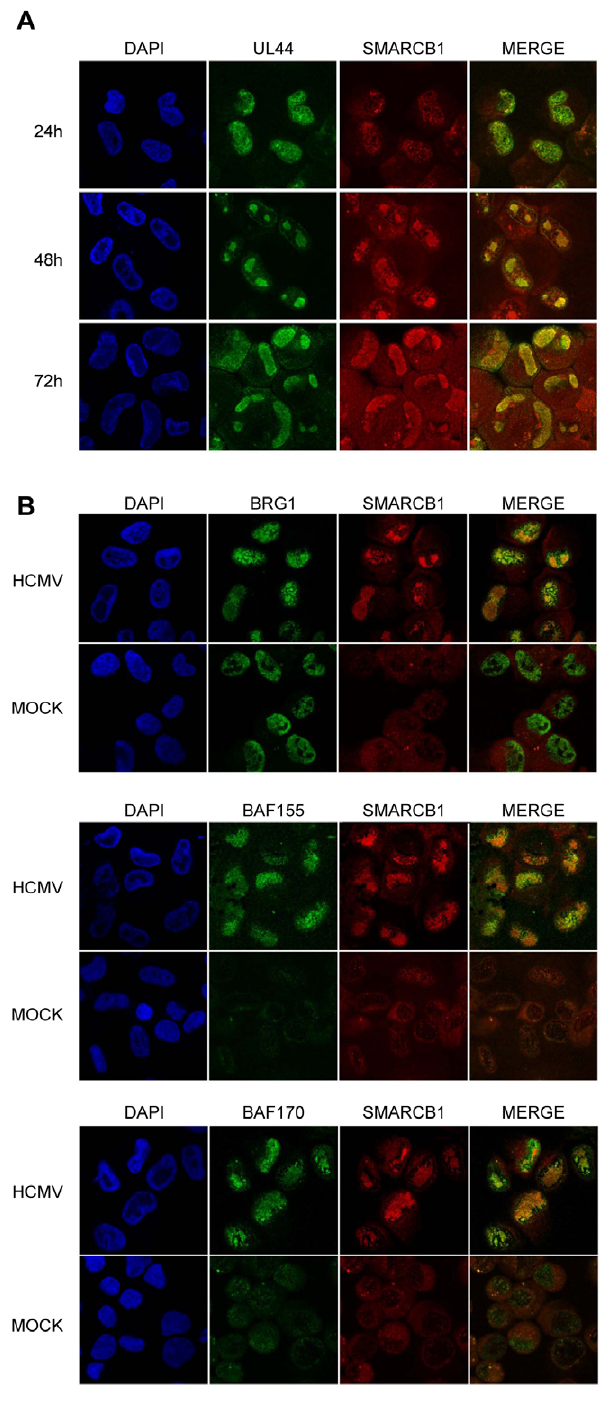
Figure 3. Recruitment of SWI/SNF chromatin remodeling factors to nuclear virus DNA replication foci. ( A ) SMARCB1 co- localizes with UL44 in HCMV-infected fibroblast cells harvested at 24, 48, and 72 hpi. ( B ) Co-localization of SMARCB1 and other essential factors of the SWI/SNF complex; BRG-1, BAF155, BAF170, in HCMV infected fibroblast cells harvested at 48 hpi. The cells were fixed and subjected to double-staining for UL44 (mouse Mab-UL44) and SMARCB1 (rabbit Pab-SMARCB1) and SMARCB1 (rabbit Pab-SMARCB1) and either BRG-1 (mouse Mab-BRG-1), BAF155 (mouse Mab BAF155), BAF170 (mouse Mab BAF170) for immunofluorescence microscopy. Secondary antibodies were used for staining UL44, BRG-1,